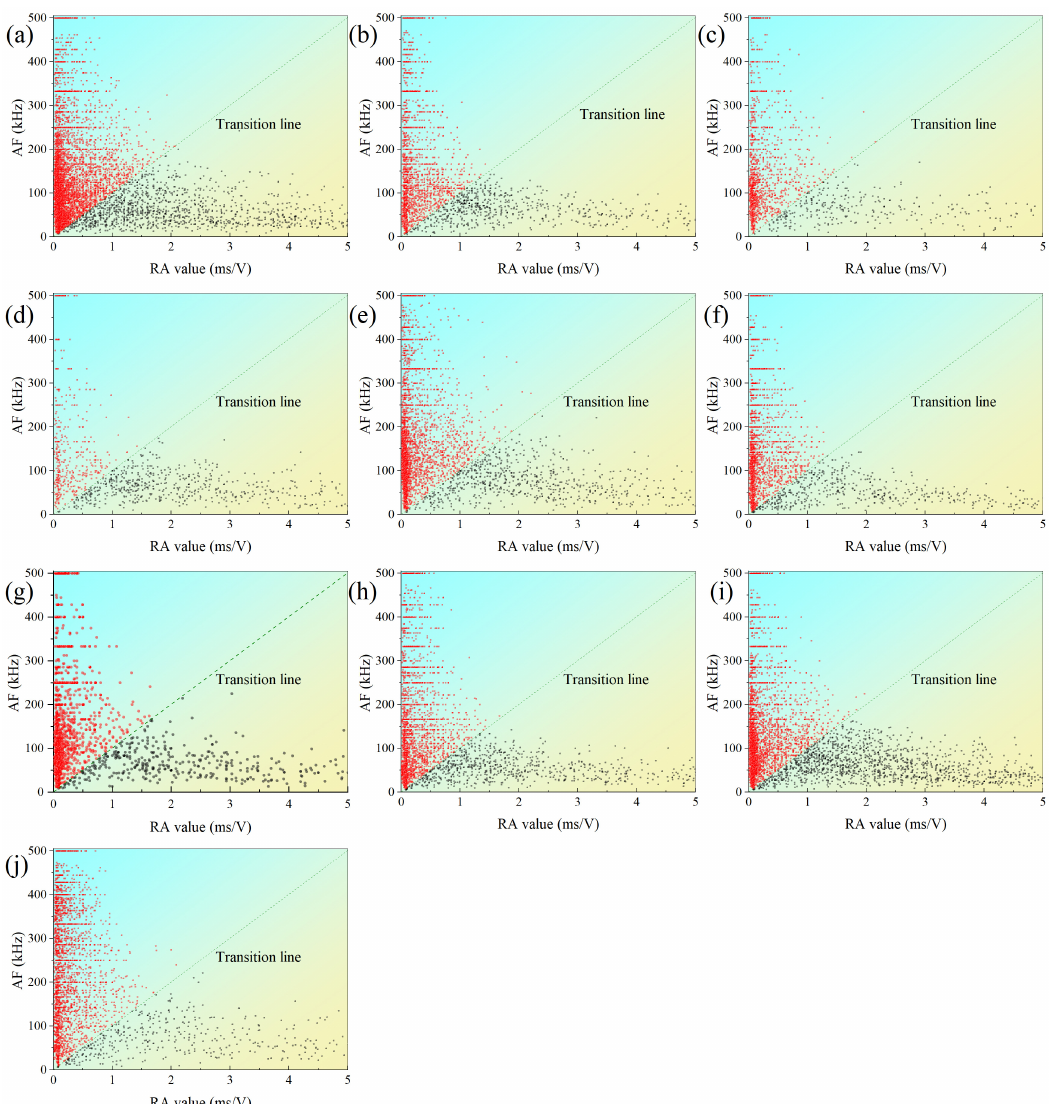
Figure 10. Classification of tensile and shear cracks based on AE parameter analysis: ( a ) Graphical representations of AE characteristic parameters; ( b ) Comparison between typical waveform of ten- sile event and shear event; ( c ) Crack classification methods in AE parameter analysis.